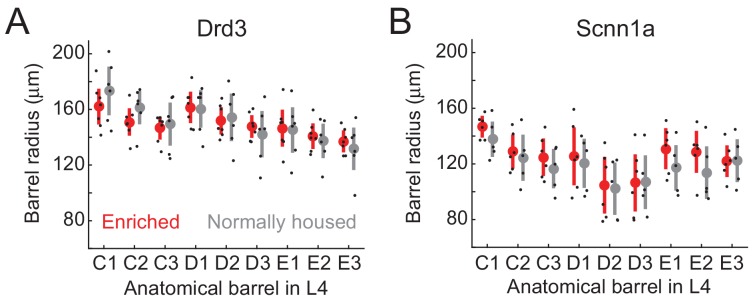
Size of L4 barrels in enriched vs. normally housed mice.(A) Radius for each of 9 anatomical whisker barrels, in Drd3-Cre mice. Red and gray show mean ± SEM for EN and NH mice. Black dots are individual mice. (B) Same measurement for Scnn1a-Cre mice. For each panel, a 2-way ANOVA was performed with factors of enrichment and barrel identity. There was no significant enrichment effect for either genotype.